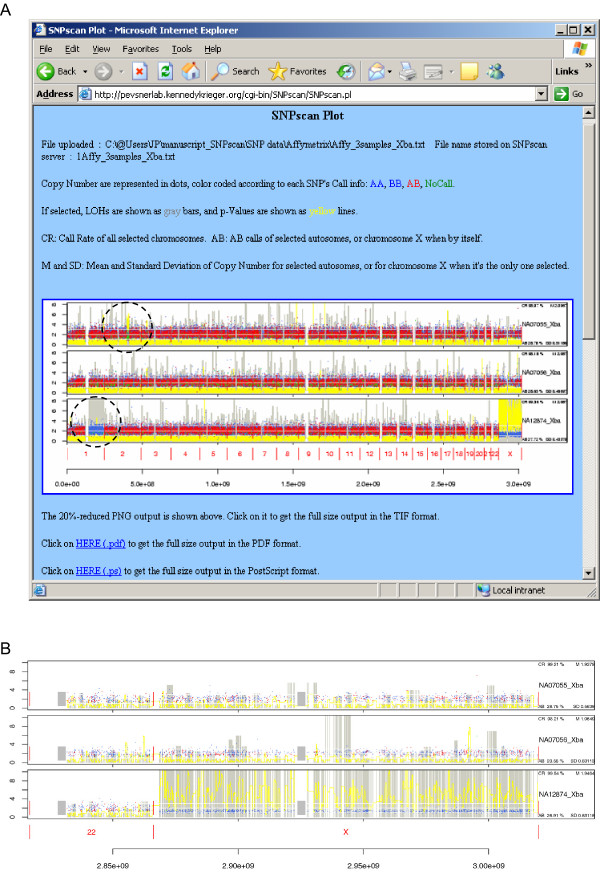
SNPscanPlot visualizes data on SNP genotype and copy number. A. Screen capture of SNPscanPlot output for three cases (NA07055, NA07056, NA12874). Each SNP array data set is organized in a row; options for types of input are 10 K, 50 K (Hind or Xba), or 100 K (combined Hind and Xba) arrays. The x-axis spans chromosomes 1–22 and X, with centromeres indicated (grey rectangles; see panel B for enlarged view). Note that a male case (bottom row) is easily distinguished from female cases by the profile of the hemizygous X chromosome, including many homozygous calls (blue dots), significant LOH -log10 p values (grey background), and a significant -log10 p value for copy number changes (yellow background). Also of note are a deletion on chromosome 2 (top row, dashed circle) and a region of UPD across chromosome 1 (bottom row, dashed circle). B. SNPscanPlot allows an expanded view of any chromosome(s); 22 and X are shown for the cases in panel A, highlighting the differences observed between male and female X chromosome SNP profiles.